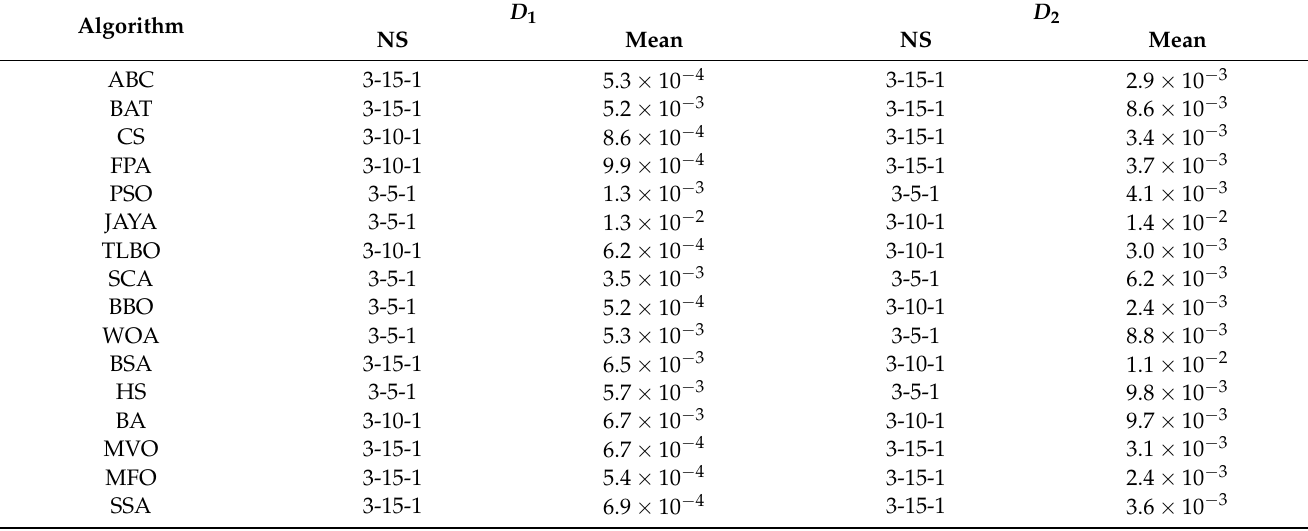
Table 9. The best training results obtained with the relevant metaheuristic algorithms for D 1 and D 2 (NS: network